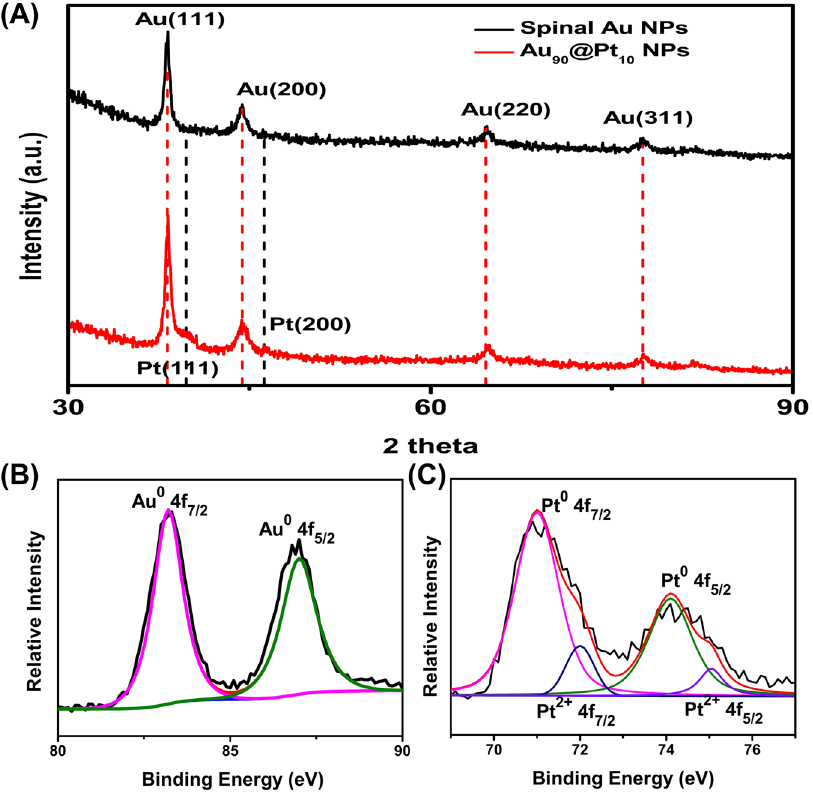
Figure 3. ( A ) XRD pattern of the Au 90 @Pt 10 NPs. ( B ) Au 4 f and ( C ) Pt 4 f XPS spectra of the Au 90 @Pt 10